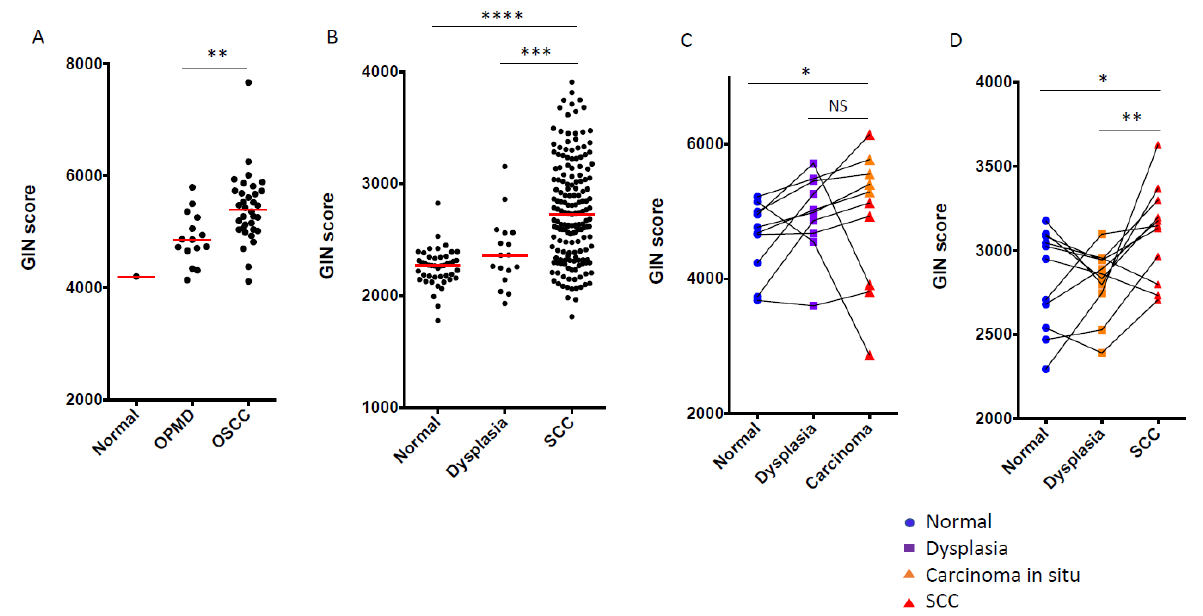
Figure 3. Dynamics of GIN score during oral carcinogenesis. In order to assess its dynamics